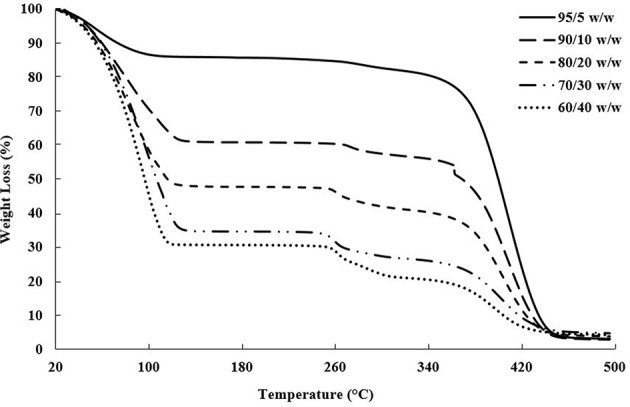
TGA plot of weight loss vs. temperature showing the evaporation of water near 100°C, followed by the CNC degradation between 260 and 280°C and PEGDA degradation between 350 and 450°C (Camarero Espinosa et al., 2013; Reid et al., 2017; Ronca et al., 2018).